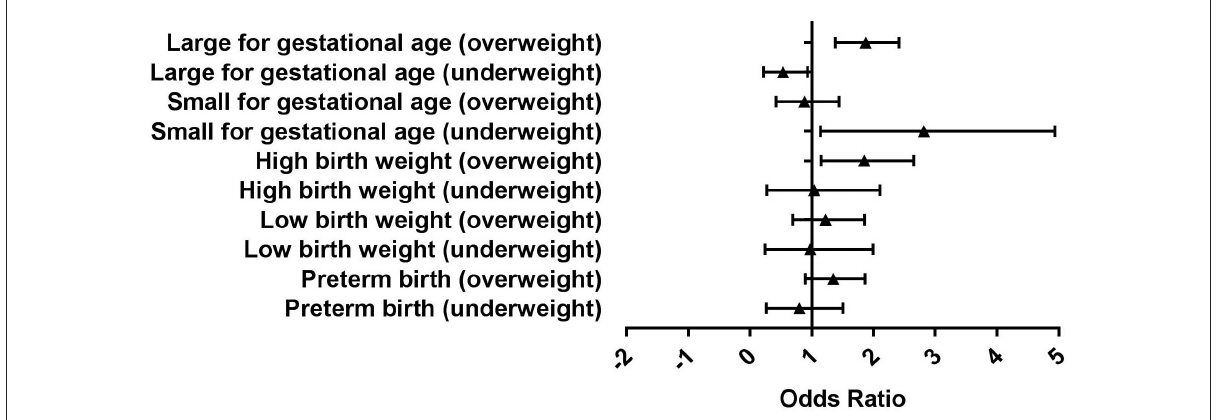
FIGURE1 Adjusted odds ratios (ORs) of adverse neonatal outcomes among singletons with different maternal body mass index